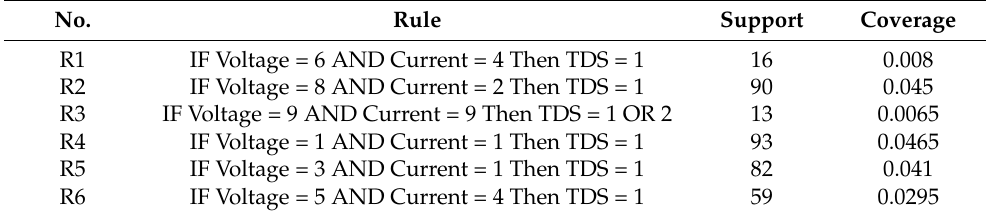
Table 8. Sample of results of Relay#12’s